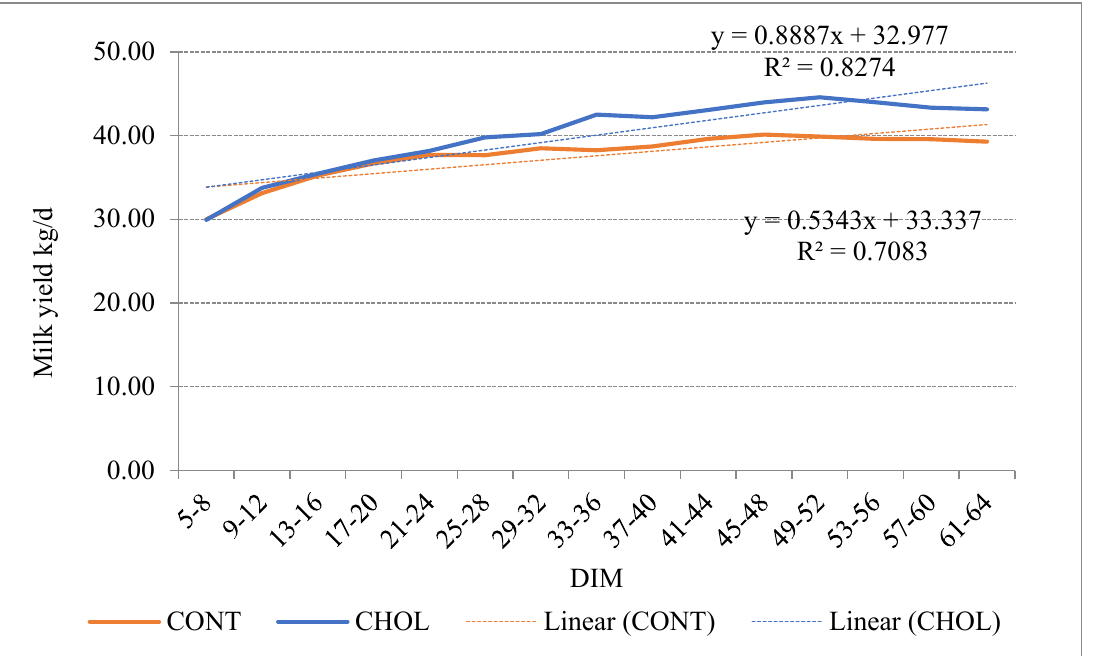
y = 0.5343x + 33.337